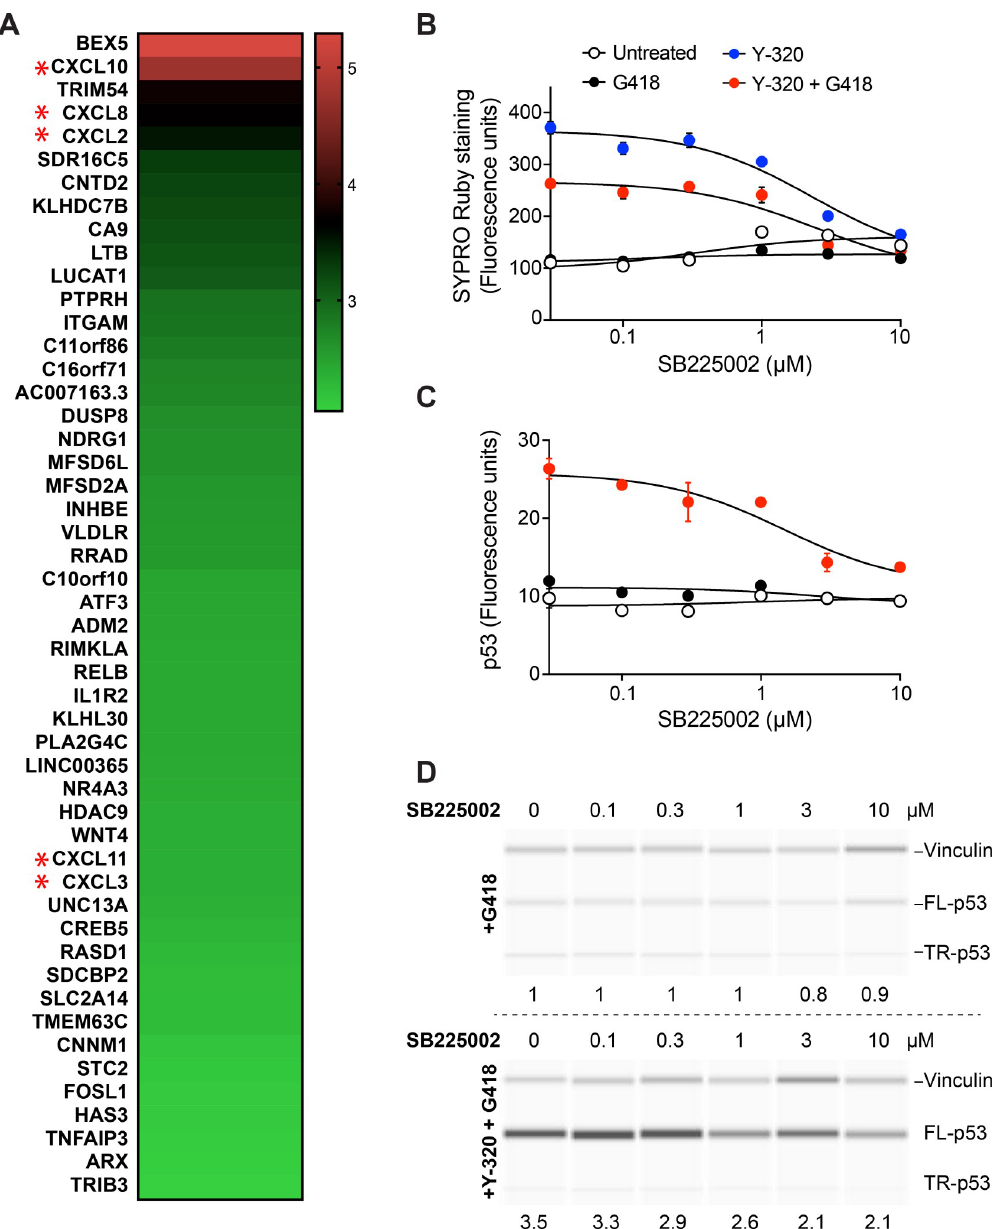
Fig 7. Up-regulation of CXC chemokines by Y-320 and effect of SB225002 on protein levels and PTC readthrough. (A) Heat map of RNA-seq data of the 50 genes with highest RNA expression level in HDQ-P1 cells treated with 1 μ M Y-320 for 48 h relative to untreated cells. CXCL genes are marked with red asterisks. The underlying data for the RNA-seq heat map can be found in the GEO database (accession number GSE152142). Key bar = log 2 fold change. (B) SYPRO Ruby protein staining. HDQ-P1 cells treated with 200 μ M G418, 2 μ M Y-320, 200 μ M G418 + 2 μ M Y-320, and different concentrations of SB225002 (Selleck Chemicals S7651) for 48 h were stained using SYPRO Ruby. Data were collected by automated fluorescence microscopy (mean ± SD; n = 4). (C, D) Effect of SB225002 on PTC readthrough. HDQ-P1 cells were treated as in B, and readthrough was analyzed by automated fluorescence microscopy (mean ± SD; n = 3) (C) and p53 automated capillary electrophoresis western analysis (D). In panel D, the area under the full-length p53 peaks was first normalized to the vinculin loading control and then divided to that of G418 alone to provide lane-to-lane comparison. These numbers are displayed under the lanes. Uncropped images of automated capillary electrophoresis western analyses are provided in S1 Raw Images, and numerical data underlying the plots can be found in S5 Data. FL-p53, full-length p53; PTC, premature termination codon; RNA-seq, RNA sequencing; TR-p53, truncated p53.